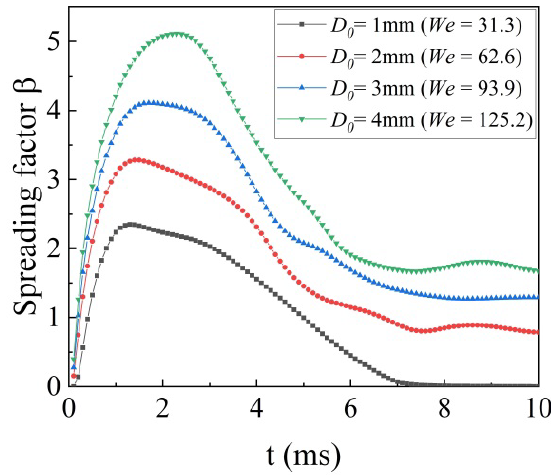
Figure 7. Time evolution of droplet-spreading factors with different droplet diameters ( V = 1.5 m/s and T s = 500 K).